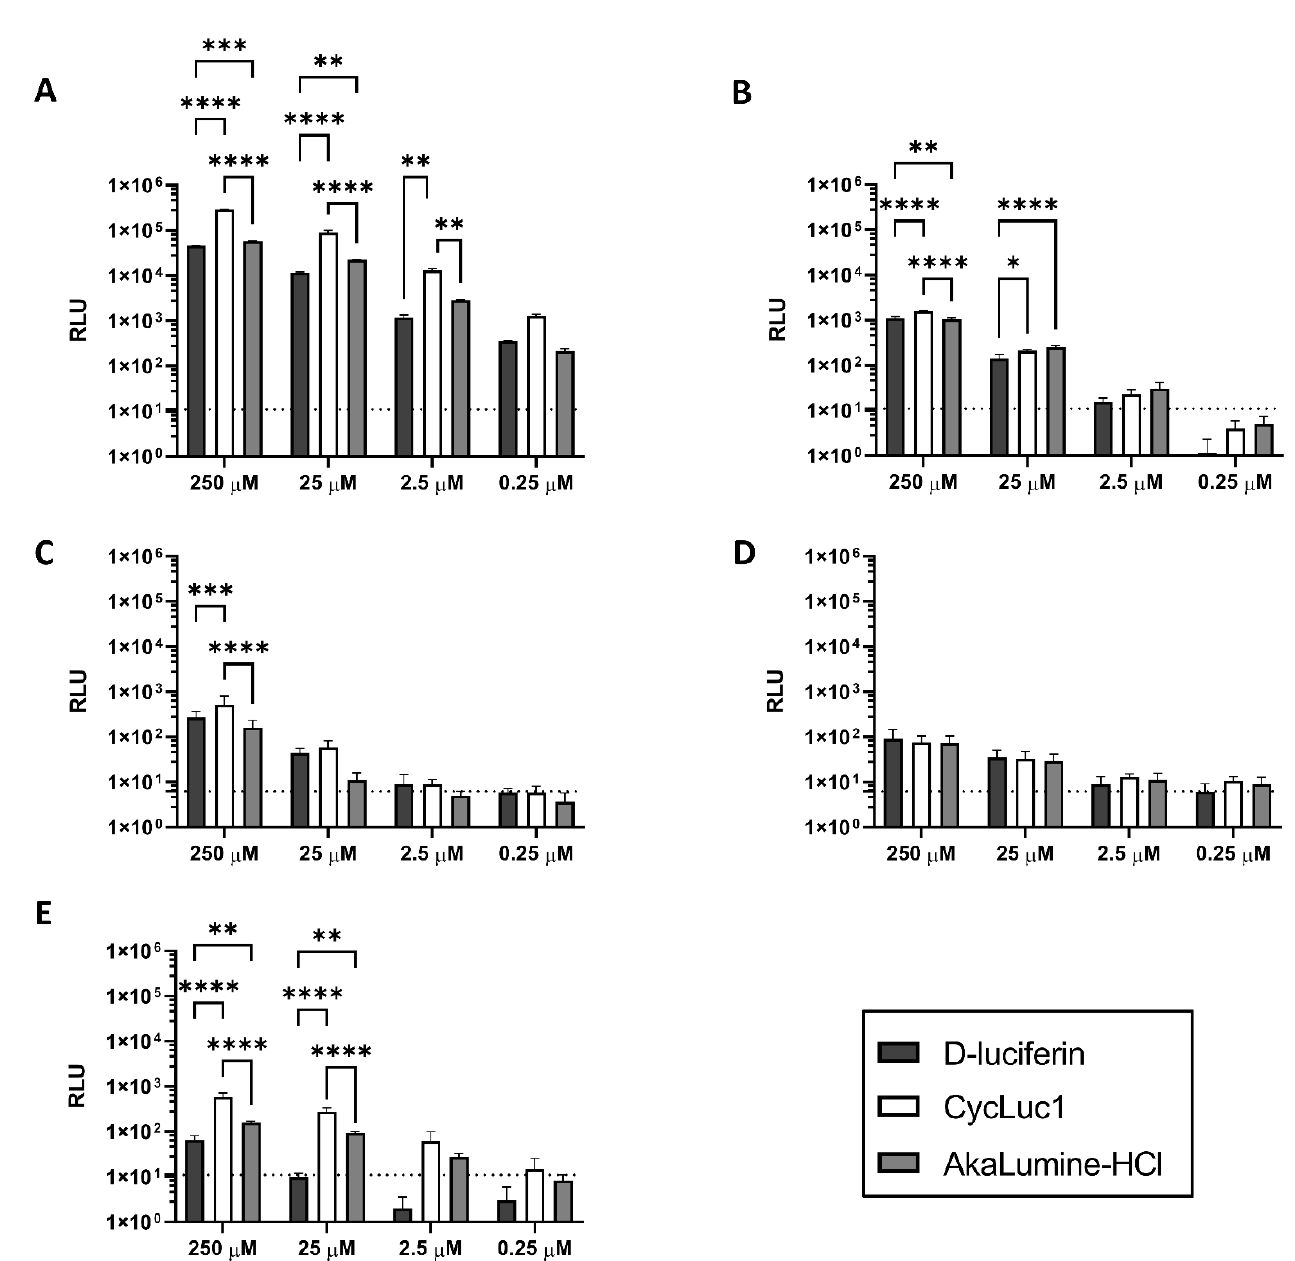
Figure 1. In vitro bioluminescence of different concentrations of D-luciferin, CycLuc1 and AkaLumine-HCl. ( A ) In vitro bioluminescent signal of L. infantum LLM-2346 PpyRE9 promastigotes and ( B ) L. major JISH118 PpyRE9 promastigotes; ( C ) In vitro bioluminescent signal of L. infantum LLM-2346 PpyRE9 amastigote-infected mouse peritoneal macrophages and ( D ) L. major JISH118 PpyRE9 amastigote-infected mouse peritoneal macrophages; ( E ) In vitro bioluminescent signal of T. brucei brucei AnTAR1.1 PpyRE9 parasites. The representative figures show the average luminescence (expressed in relative luminescence units (RLU) [p/s/cm 2 /Sr]) produced in at least two independent repeat experiments, each conducted in triplicate. Dotted lines represent the background signal. Results are expressed as mean luminescent signal ± SD (* p ≤ 0.05, ** p ≤ 0.01, *** p ≤ 0.001 and **** p ≤ 0.0001). When comparing the efficacy of the substrates against T. brucei , the addition of CycLuc1 also resulted in higher luminescence (Figure 1E), albeit only statistically significant at the two highest concentrations tested (F (6, 60) = 46.04, p < 0.0001). Given the comparable in vitro efficacy, all substrates were also tested in subsequent in vivo